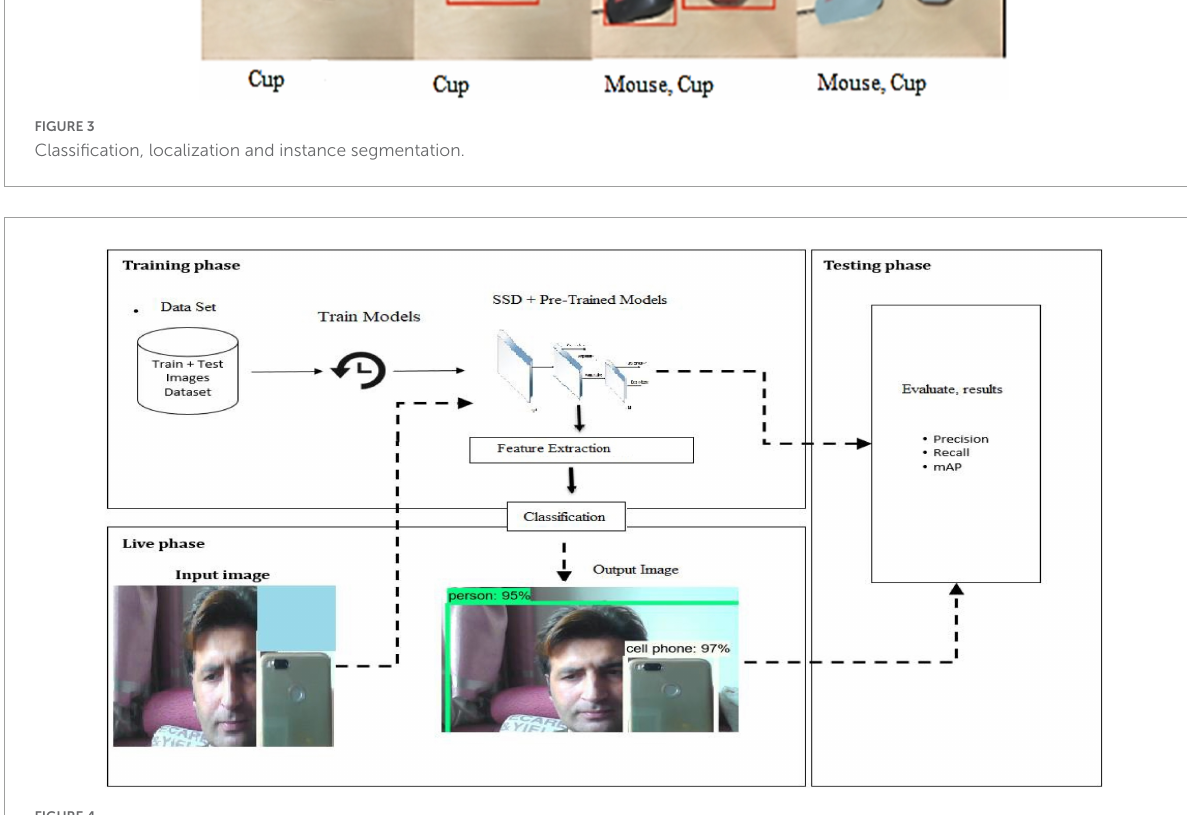
FIGURE4 The flow chart of the deep learning